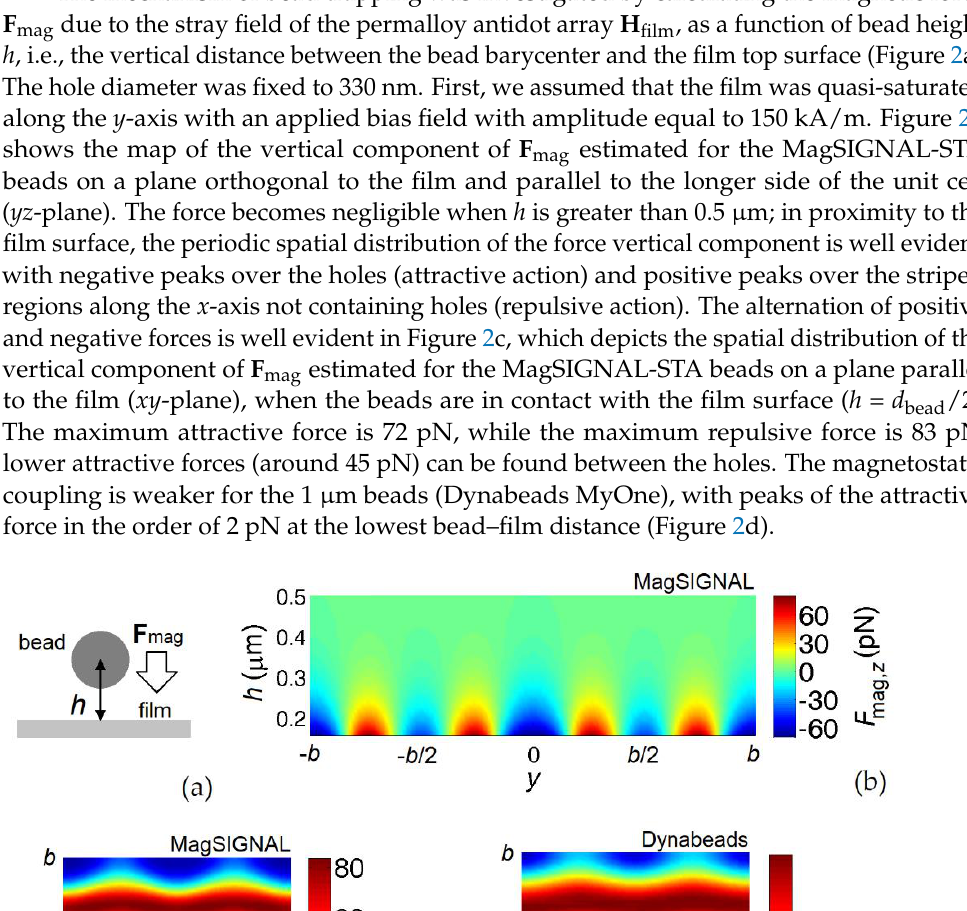
Figure 3. Maps of the vertical component of the magnetic force calculated on a plane parallel to the permalloy nanostructured film for MagSIGNAL-STA beads, applying a bias field of ( a ) 50 kA/m and ( b ) 25 kA/m. The beads are assumed to be in contact with the film surface.